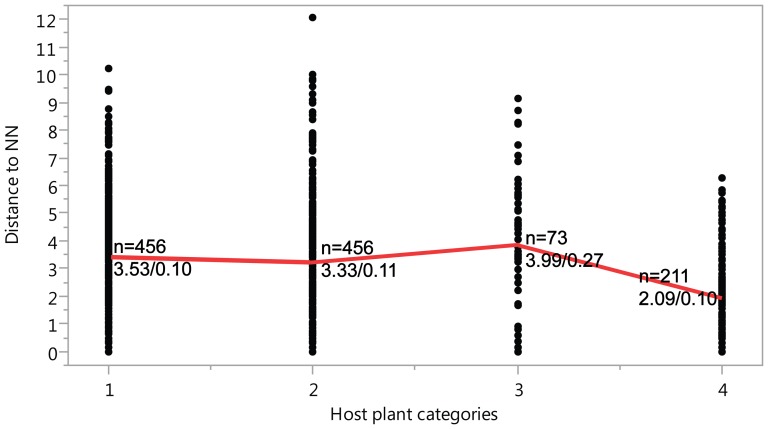
Impact of host plant type on NN distances.Nearest-Neighbour (NN) distances for species of Canadian noctuoids using four food plant categories: 1) monocots or herbaceous dicots, 2) trees or shrubs, 3) detritus, fungi and lichens, and 4) generalist. Values above the bars indicate the number of species in each food plant category (n), average of NN/standard errors (SE).